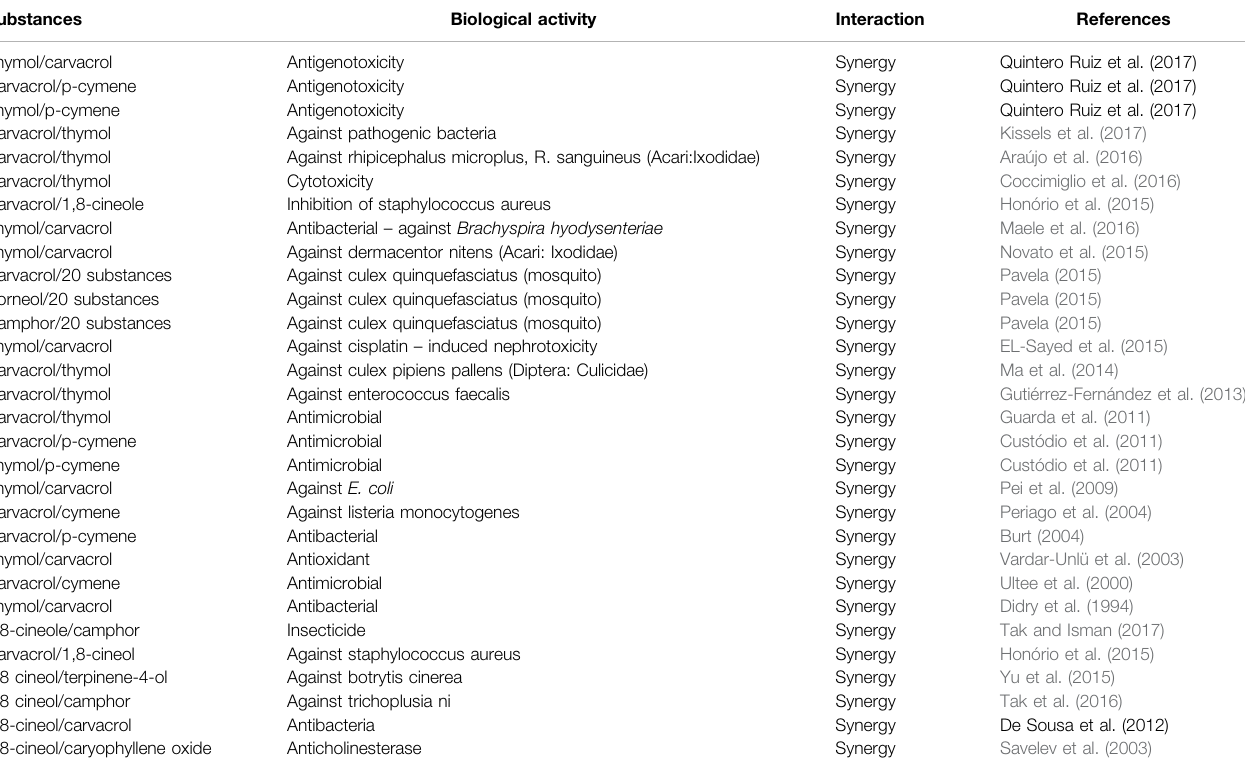
TABLE5| Synergisticinteractionsofcarvacrol,eucalyptoland β -Caryophyllene.Synergisticinteractionsofminorconstituentsoftheessentialoilreportedinthesamearticles are also